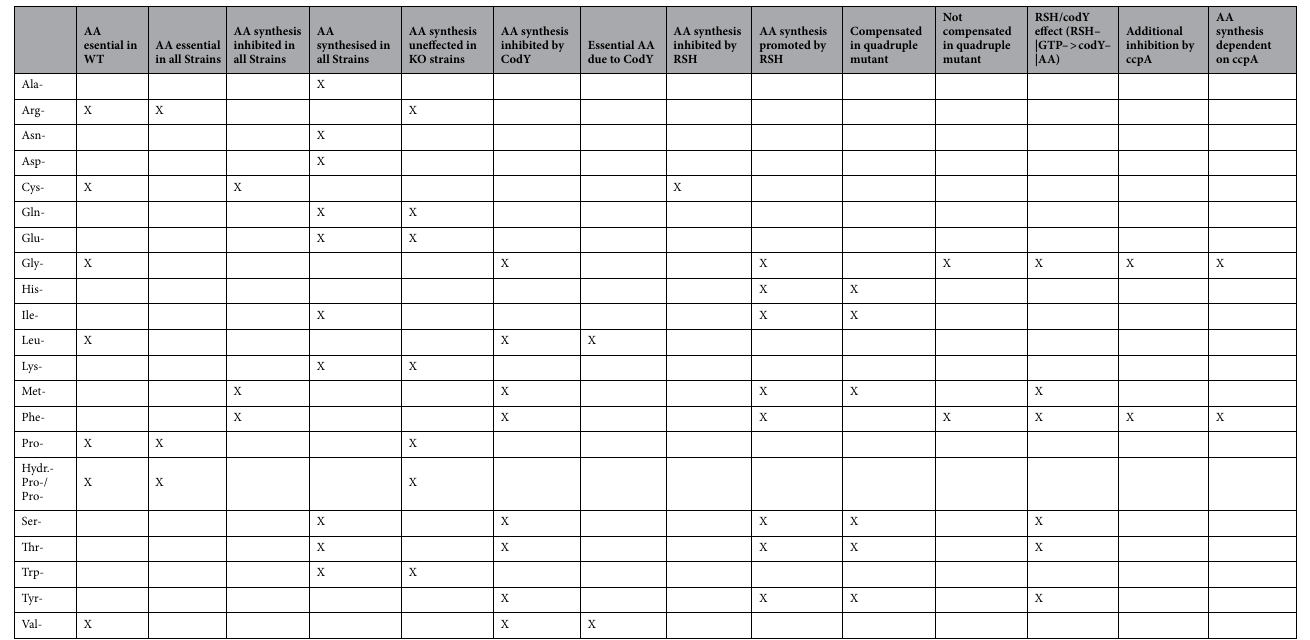
Table 2. Essential and modulated AA. This table shows the essential AA as well as the influence of different central nodes on the synthesis of the different